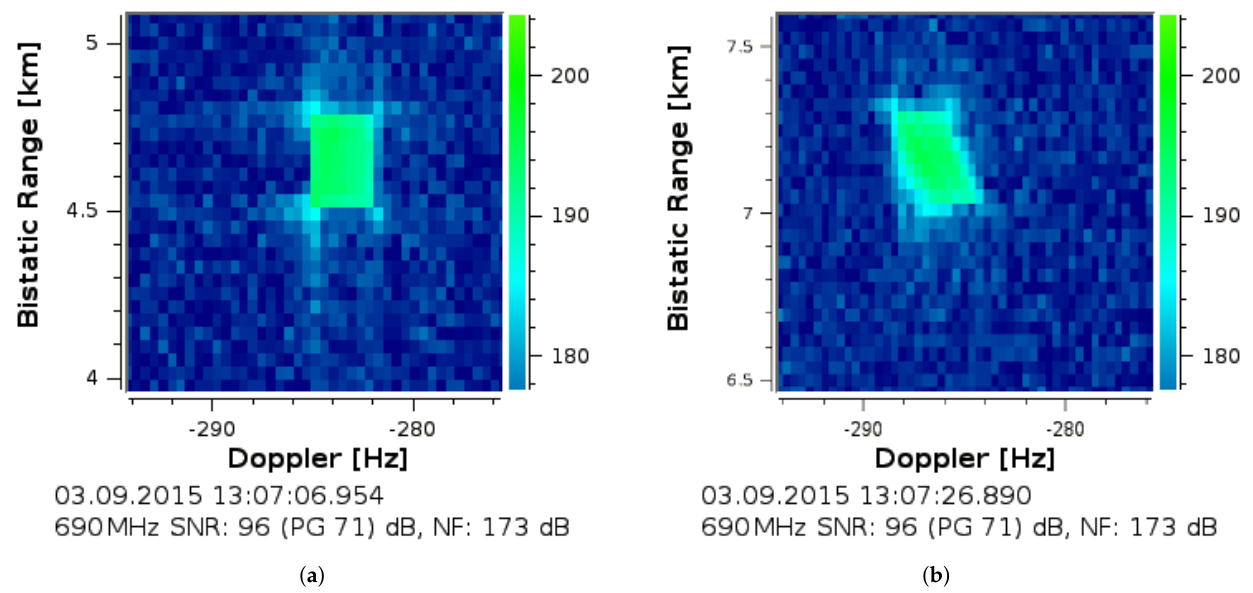
Figure 6. Strong departing target return with a segment of constant effective bistatic velocity and slight acceleration processed with increased T int = 1.79s and T cov = 2.24s with 1/4 as guard interval fraction. ( a ) Constant bistatic v eff ≈ − 220km/h. ( b ) Slightly accelerated at v eff ≈ −